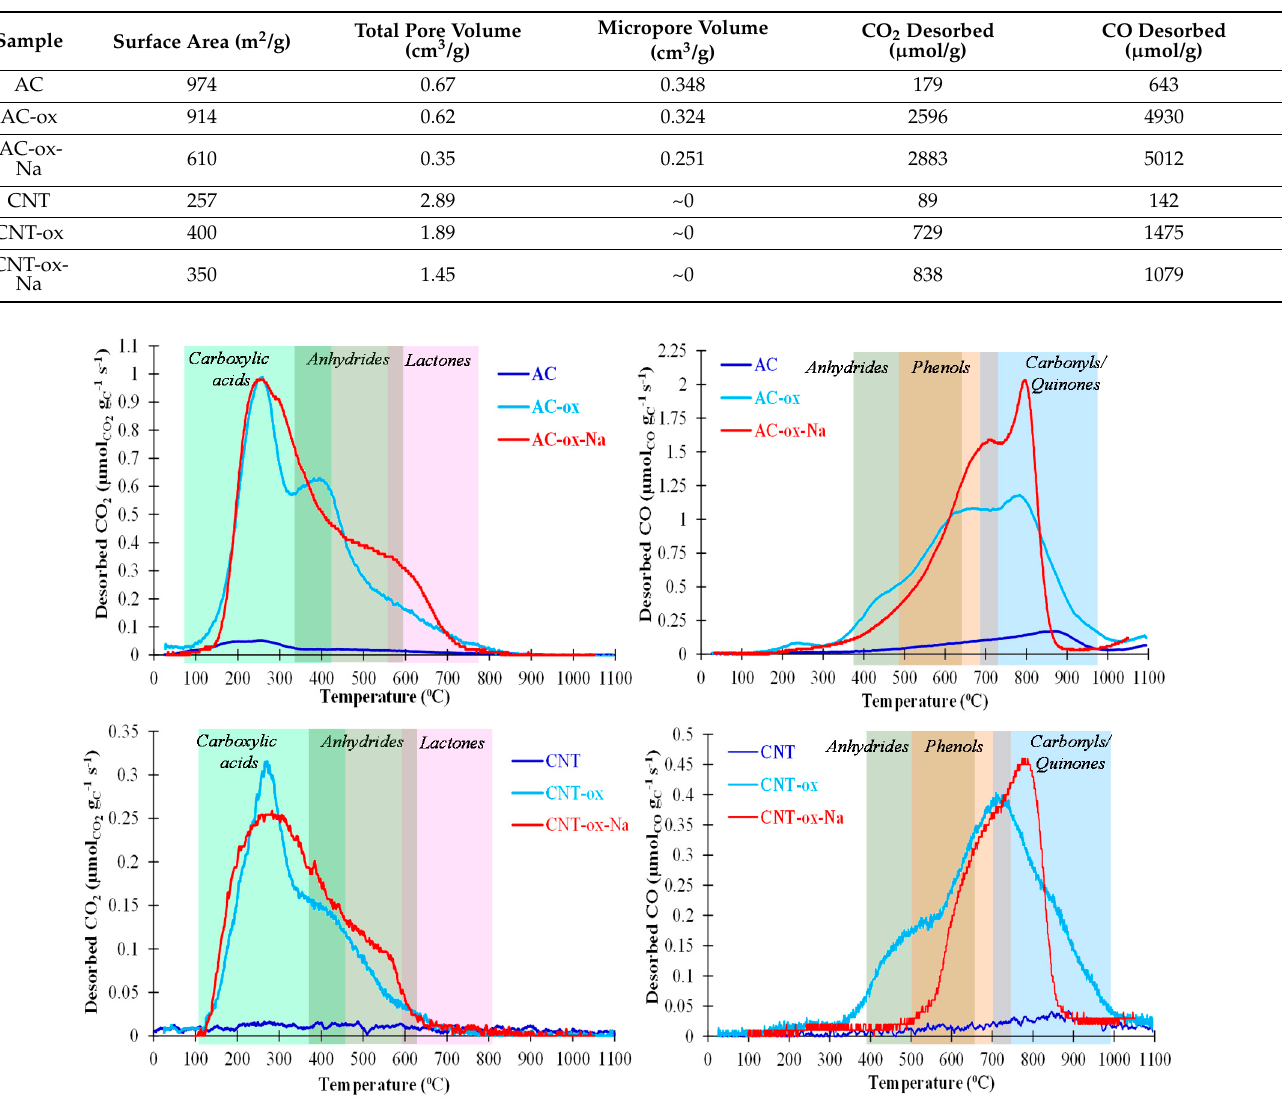
Figure 3. TPD profiles for AC ( top ) and CNT ( bottom ). The desorption of CO 2 ( left ) and CO ( right ) is shown with the identification (in color bars) of the types of groups that desorb at different temperature ranges (adapted from [13]). Table 2. Characterization of carbon supports: surface area, total pore volume and micropore volume obtained by adsorption of N 2 at − 196 °C and amounts of CO and CO 2 desorbed, determined by TPD (adapted from [13]). Sample